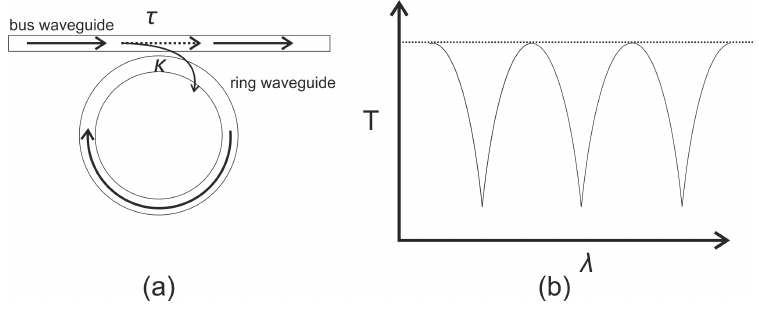
Figure 12. ( a ) schematic of MRR ( b ) transmission spectrum of MRR (based on reference